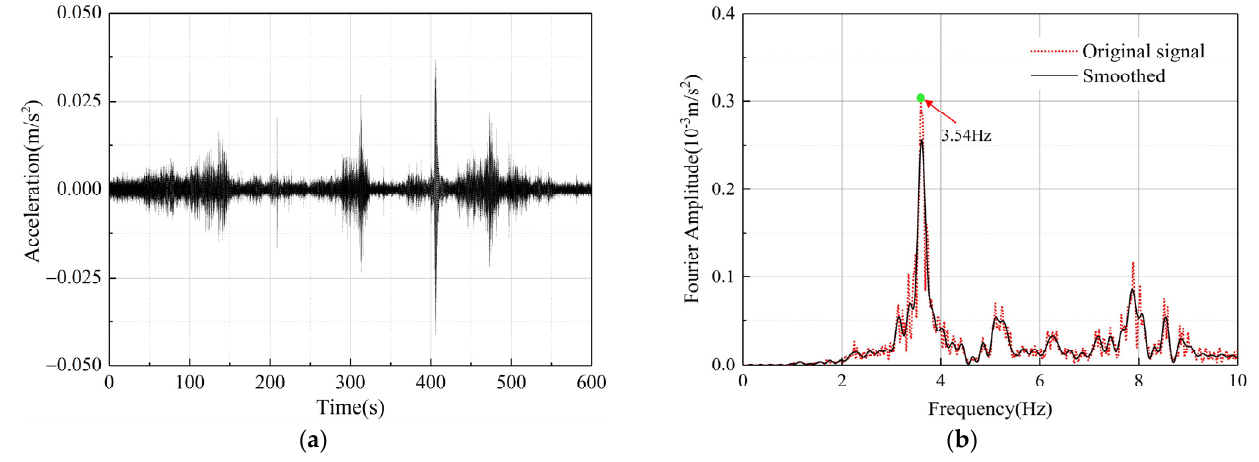
Figure 4. Acceleration response and corresponding FFT spectra of the suspended floor at the measurement point 1 under ambient excitation: ( a ) acceleration time history; ( b ) FFT spectra.